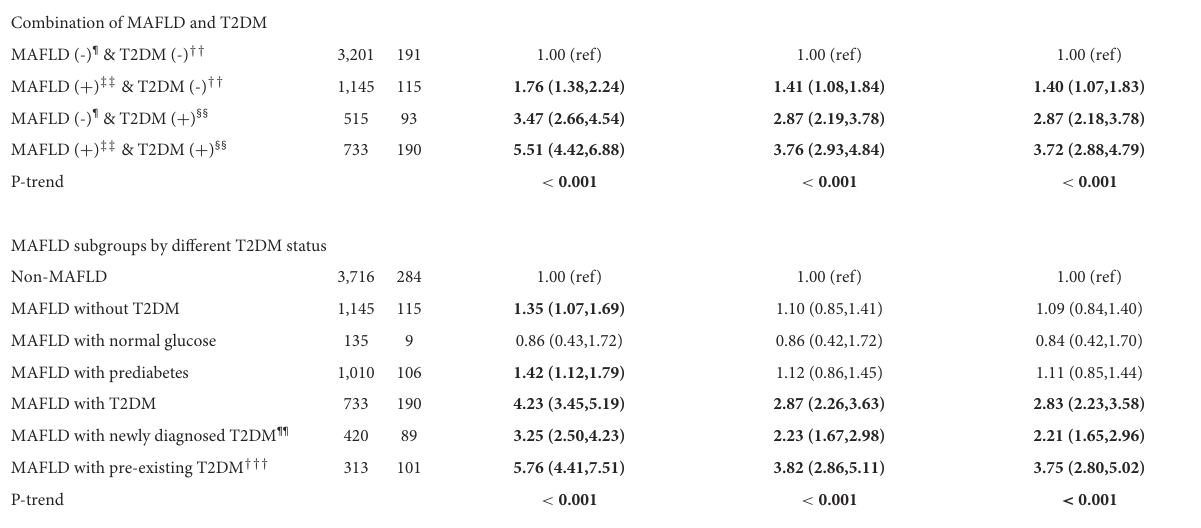
TABLE 3 Association of MAFLD and T2DM with